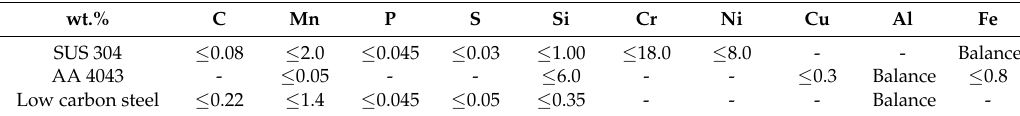
Table 1. Chemical constituents of two wires and base